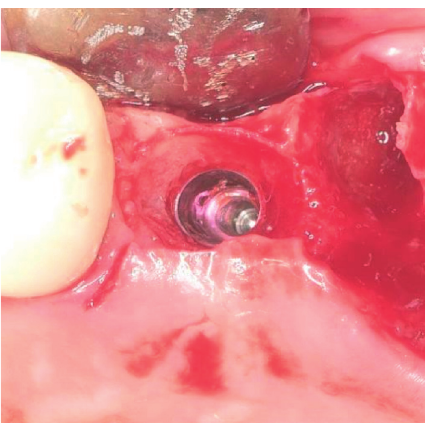
Figure 5: Preliminary bone reduction with implant placement.